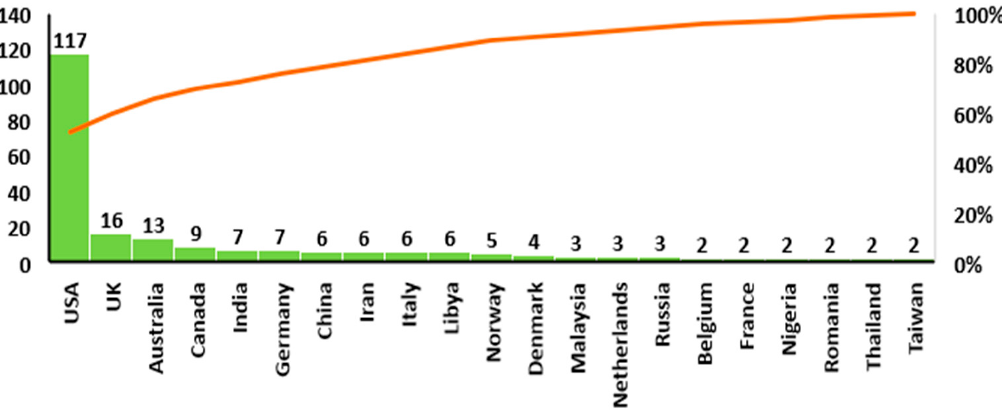
Figure 2. Distribution of published articles in the domain of healthcare management worldwide.